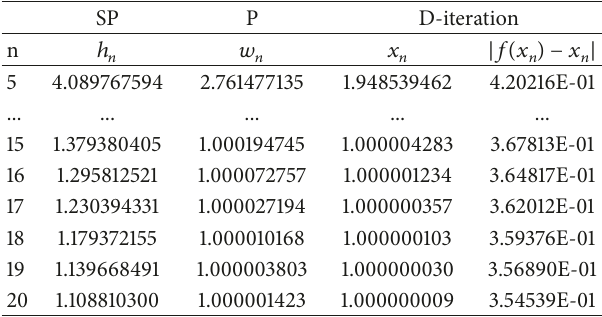
Table 1: SP-, P-, and D-iterations for 𝑓(𝑥) = (𝑥 2 + 2√𝑥 + 5)/8 .